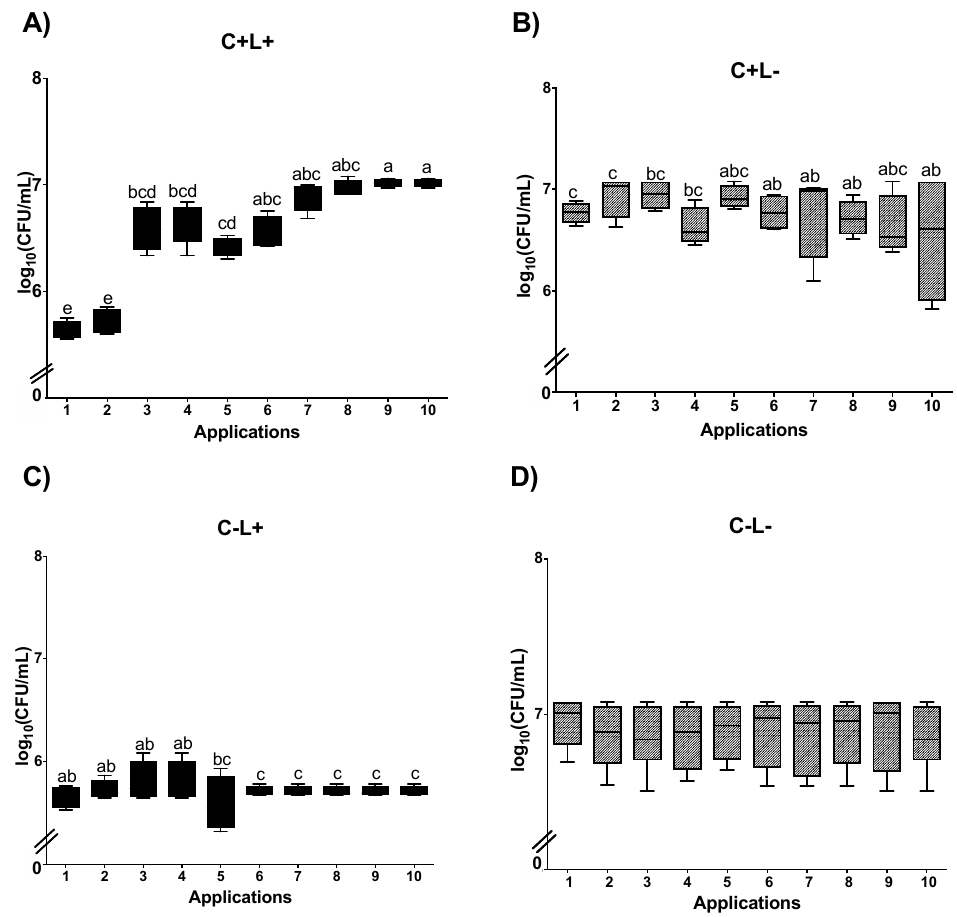
Figure 9. Log 10 values (CFU/mL) of C. albicans biofilms submitted to ( A ) aPDT (C+L+), ( B ) CUR (C+L − ), ( C ) light (C − L+), and ( D ) experiment control (C − L − ) grown in fluconazole. Upper limit of the box: third quartile; lower limit of the box: first quartile; error bars: minimum and maximum values. Different letters (a; b; c; d; e) denote statistical differences between columns (applications) according to Dunn’s post-test ( p < 0.05) ( n = 12).